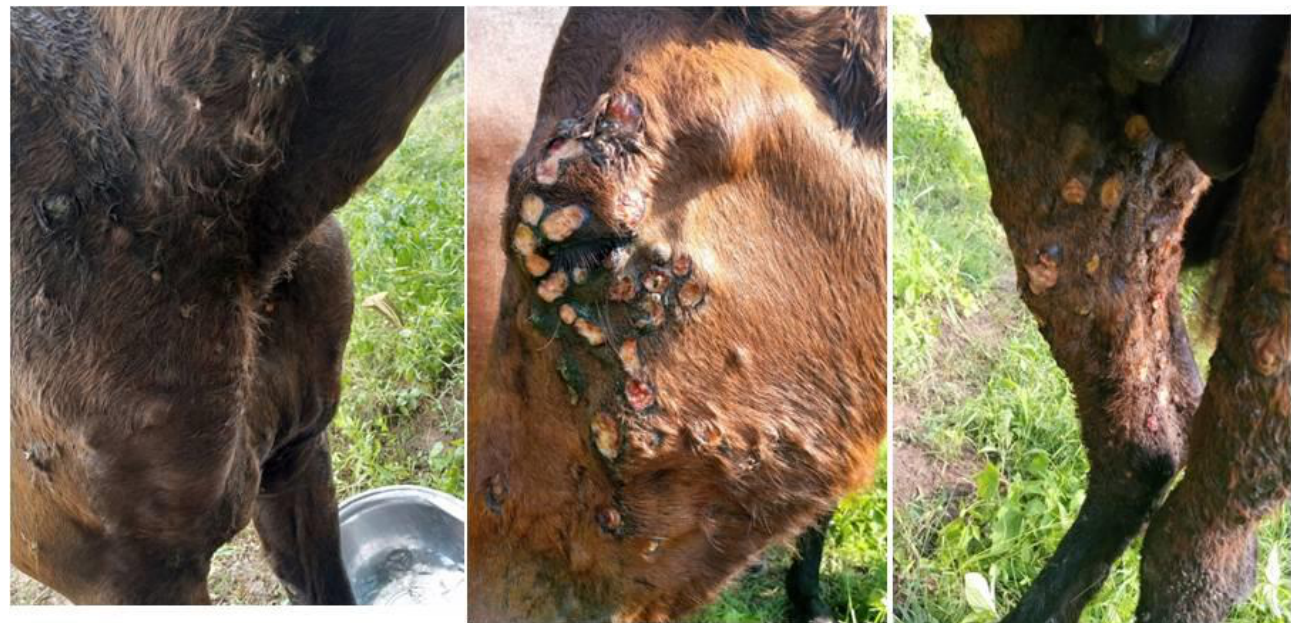
Fig. 1(left-right): nodular and ulcerative lesions around the chest, face, and limbs.